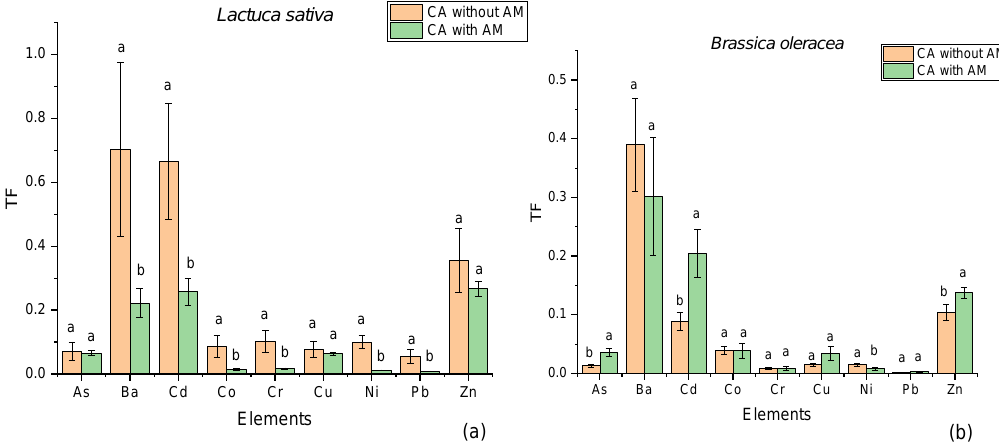
Figure 4. Bioconcentration factors (BF) of Lactuca sativa ( a ) and Brassica oleracea ( b ) grown in the polluted Ca soil with or without the amendment (AM). Letters above columns refer to the summary of multiple comparisons for pairs obtained with Tukey test. Letter b identifies BF values whose means are significantly lower than the ones obtained for the BF values identified by letter a.